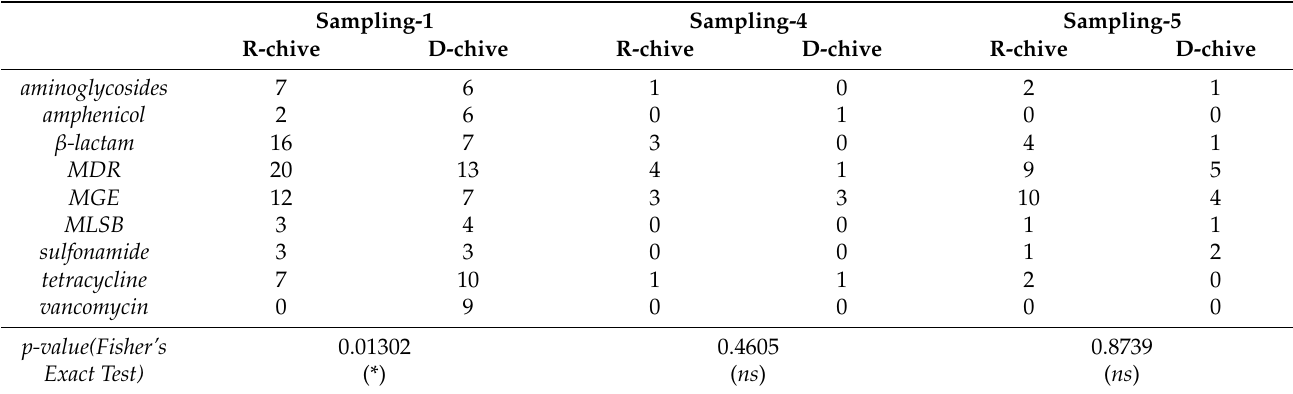
Figure 1. Fold changes of ARGs grouped by class, comparing reservoir water chive (R-chive) to tap water chive (D-chive) at three sampling time points: ( A ) freshly planted chive, ( B ) chive at harvest, and ( C ) chive at the end of its shelf life. The horizontal line marks equal abundance on both chive types. Dots above the line indicate ARGs with higher abundance on R-chive, while dots below the line indicate ARGs with higher abundance on D-chive. Numbers above and below the dots indicate counts of ARGs per class with higher abundance on R- or D-chive, respectively. Empty symbols represent ARG classes with no differentially abundant ARG. Table 1. Contingency tables of DA ARGs detected per sampling on R- and D-chive, split by ARG class. Statistical differences between R- and D-chive per sampling are shown at the bottom, as determined by Fisher’s exact test for count data (alternative hypothesis two-sided). *, p < 0.05; ns, not significant.